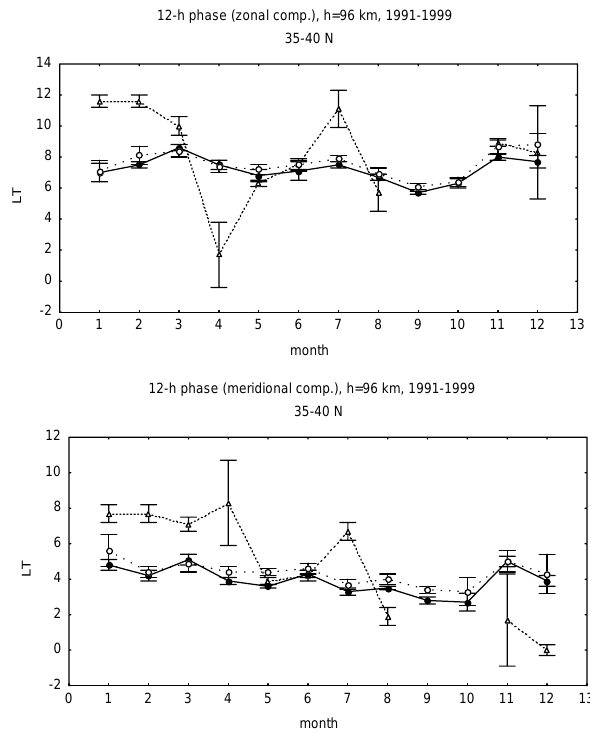
Fig. 6. Same as Fig. 2, except for phase of semidiurnal